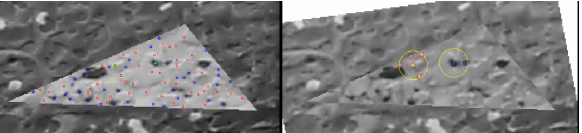
Figure 6. Low-contrast filter. Left: configuration with R = 4 , middle: 75% of contiguous neighboring points, right: 65% of non-contiguous neighboring points